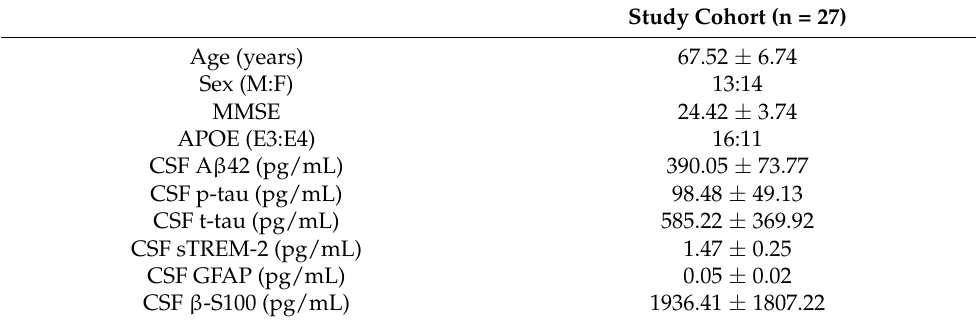
Table 1. Demographic data and CSF analysis results expressed as means ± standard